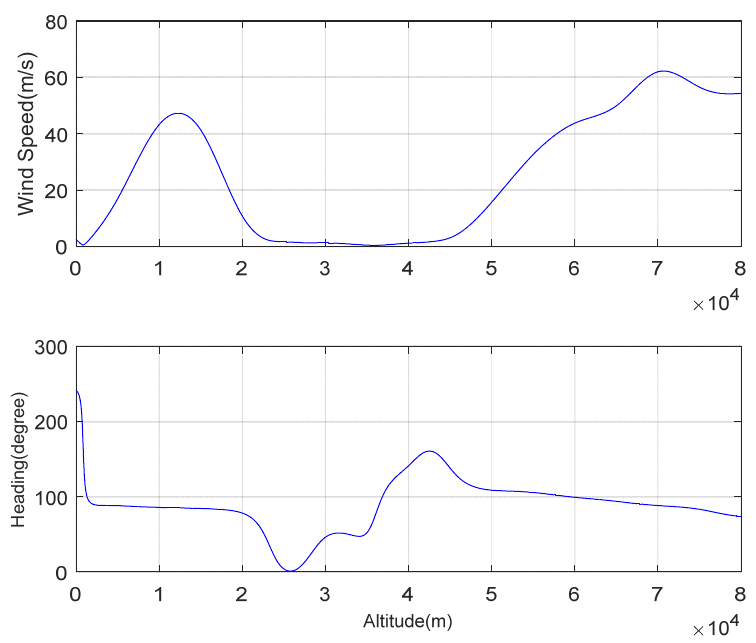
Figure 11. Variations in the wind speed and heading with altitude in Changsha (28°11 ′ 49 ″ N, 112°58 ′ 42 ″ E) obtained by the MATLAB function atmoshwm07 using the Naval Research Laboratory Horizontal Window Model.